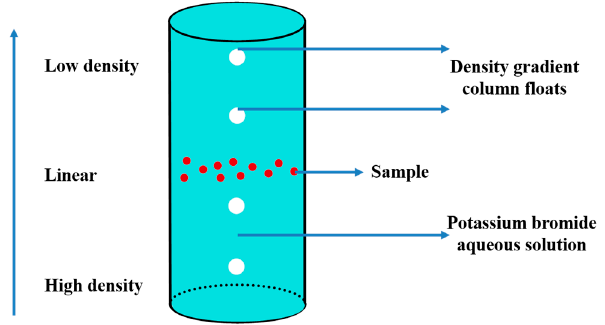
Figure 8. Schematic diagram of PDDA.